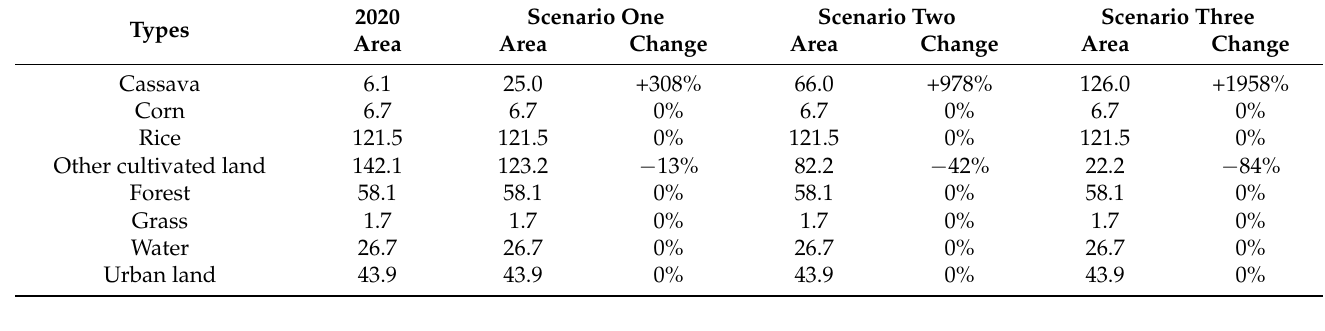
Table 7. Areas of the land-use scenarios in the Yujiang River Basin (km 2 ).